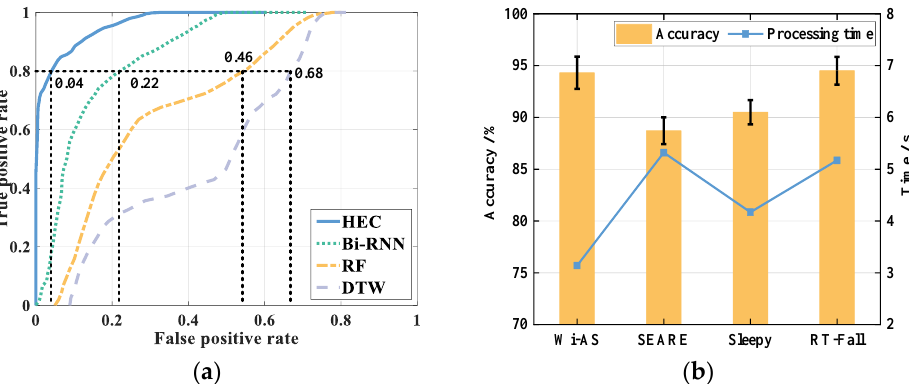
Figure 17. Comparison of different classification algorithms and systems: ( a ) comparison of different algorithms; ( b ) comparison of different systems.